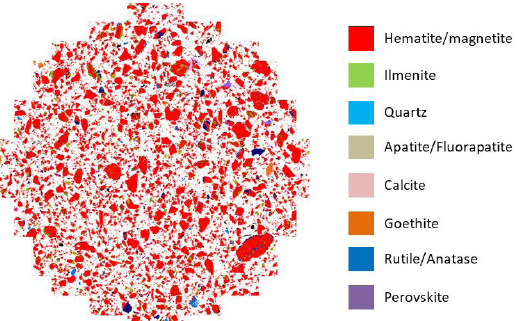
Figure 3. Phase map of the ferromagnetic tailings sample using the Quantitative Electronic Microscope (QEM).